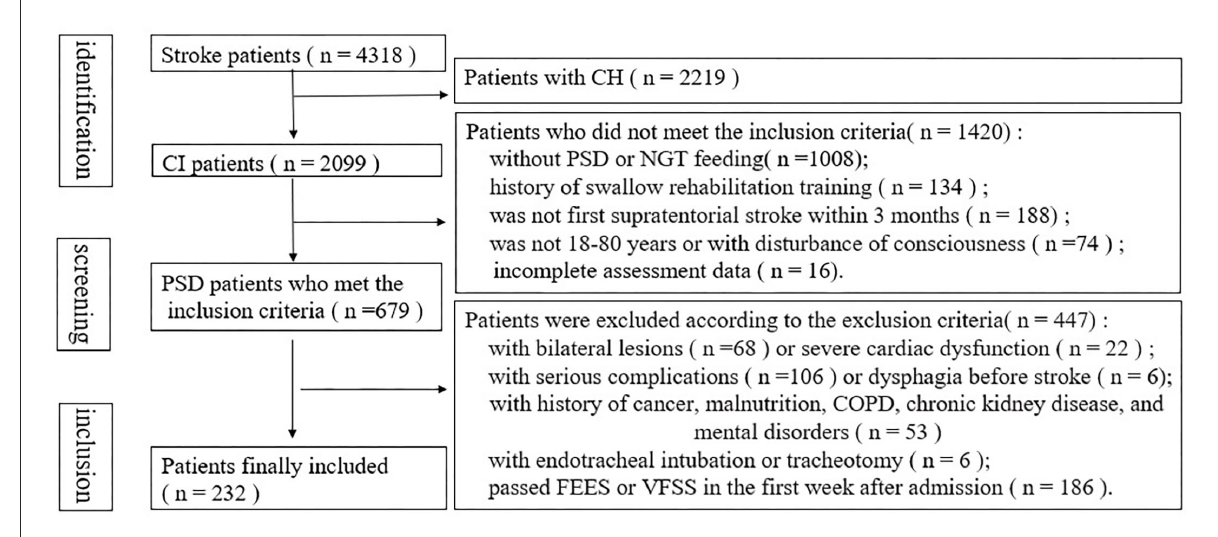
FIGURE1 Flow diagram of the selection of patients from our cerebrovascular disease database and specific reasons for exclusion.